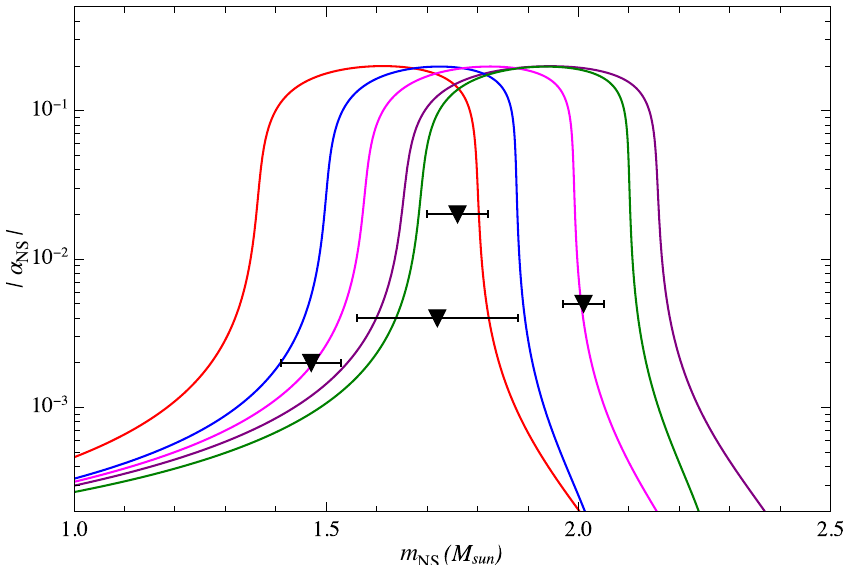
Figure 5. Effective scalar coupling α NS of a NS as function of its inertial mass m NS , to illustrate the highly non-linear mass and EOS dependence of the scalar charge of a NS. DEF gravity with α 0 = 10 − 4 and β 0 = − 4.5 was assumed. The different curves correspond to five different EOSs which we have chosen as an example (from left to right: WFF1, SLy4, ENG, MPA1, BSk22 [99,100]). The black triangles give the limits (95% C.L.) from four different pulsar-WD systems, from left to right: PSR J1738 + 0333 [Section 5.1], PSR J1012 + 5307 [101], PSR J2222 − 0137 [102], PSR J0348 + 0432 [98]. Error bars indicate one-sigma uncertainties in the pulsar